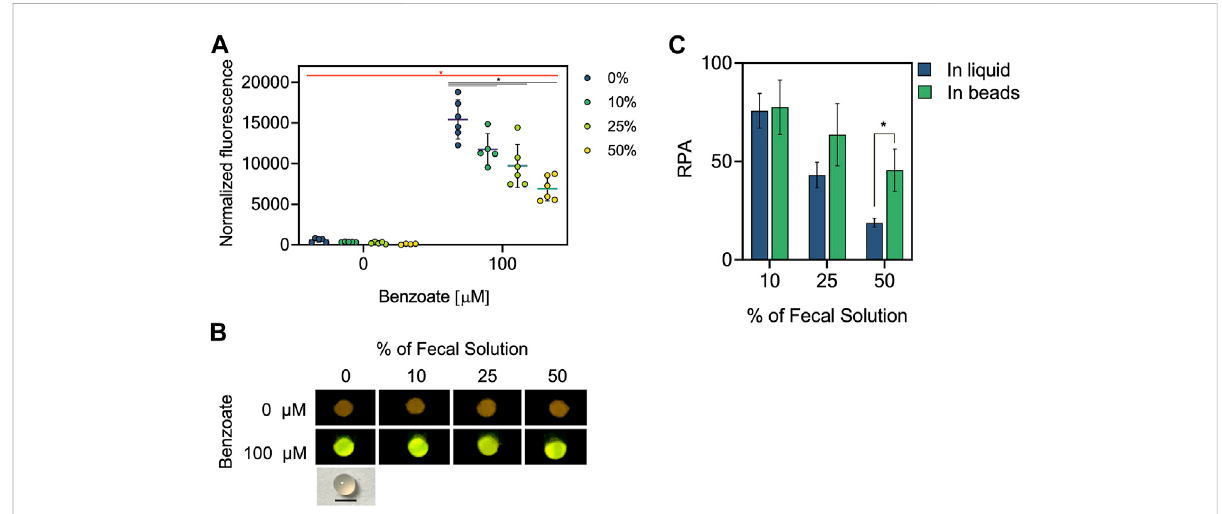
FIGURE 4 Matrix effectoffecalsolutionon theperformanceofencapsulatedBenR-pBENbiosensor. (A) Normalized fl uorescenceofencapsulated BenR- pBEN biosensor on different percentages of fecal solutions. BenR-pBEN biosensor in alginate beads was induced or not with 100 µM benzoate in presence of pooled fecal solutions from four different patients at fi nal percentages; 10%, 25%, and 50% and incubated at 37 ° C without shaking for 16 h. Fluorescence was measured by plate reader and normalized by absorbance at 600 nm. The mean value and standard deviation of beads analyzed in triplicate on two different days are plotted. *: p -value < 0.05 two-way ANOVA with Fisher ’ s LSD multiple comparisons test. The asterisk represents signi fi cant differences betweennon-induced versusinducedcondition (red)and non-fecalsolution versus differentpercentages of fecal solution (balck). (B) Photograph of biosensor beads atthe end of thesensing experiment performed (top) on different percentages of fecal solutions underbluelight.Thebiosensorbeadscontained2.5%alginateandmeasured2 mmindiameter.Blackbar:2 mm.Errorbars:±SD.RPAwascalculated as described in methods. An unpaired t-student test was performed. The asterisk represents signi fi cant differences between conditions. *: p -value